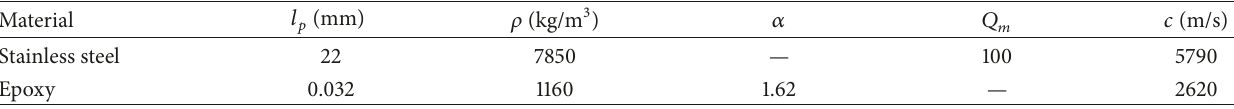
Table 2: Material properties and geometric dimensions of other parts of the